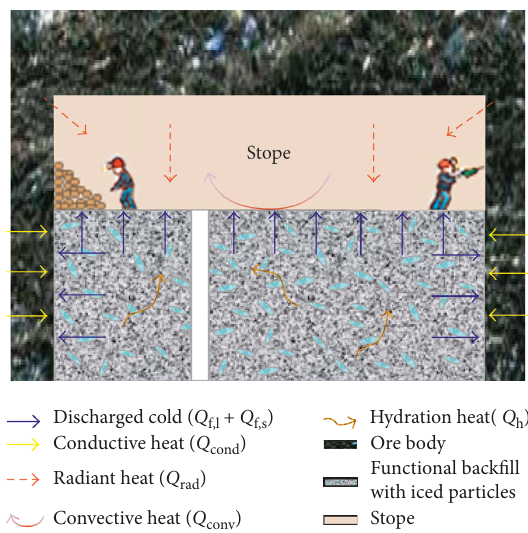
Figure 2: The total thermal equilibrium diagram of CLS phase change backfill